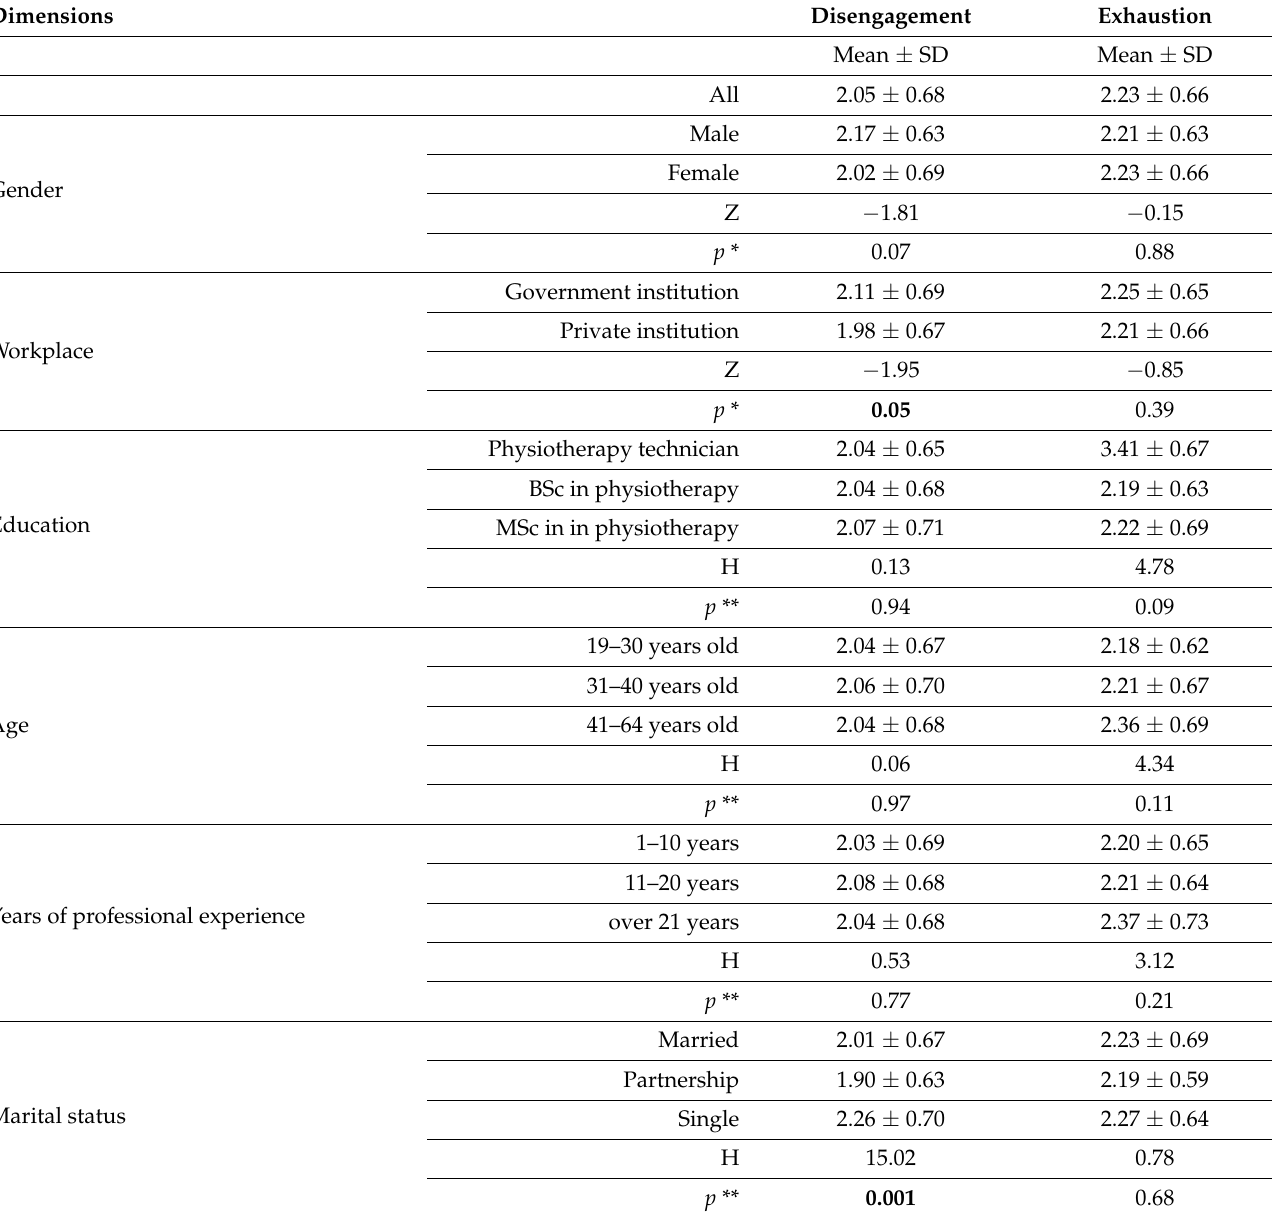
Table 3. The Oldenburg Burnout Inventory dimensions result in the study group of physiotherapists and selected